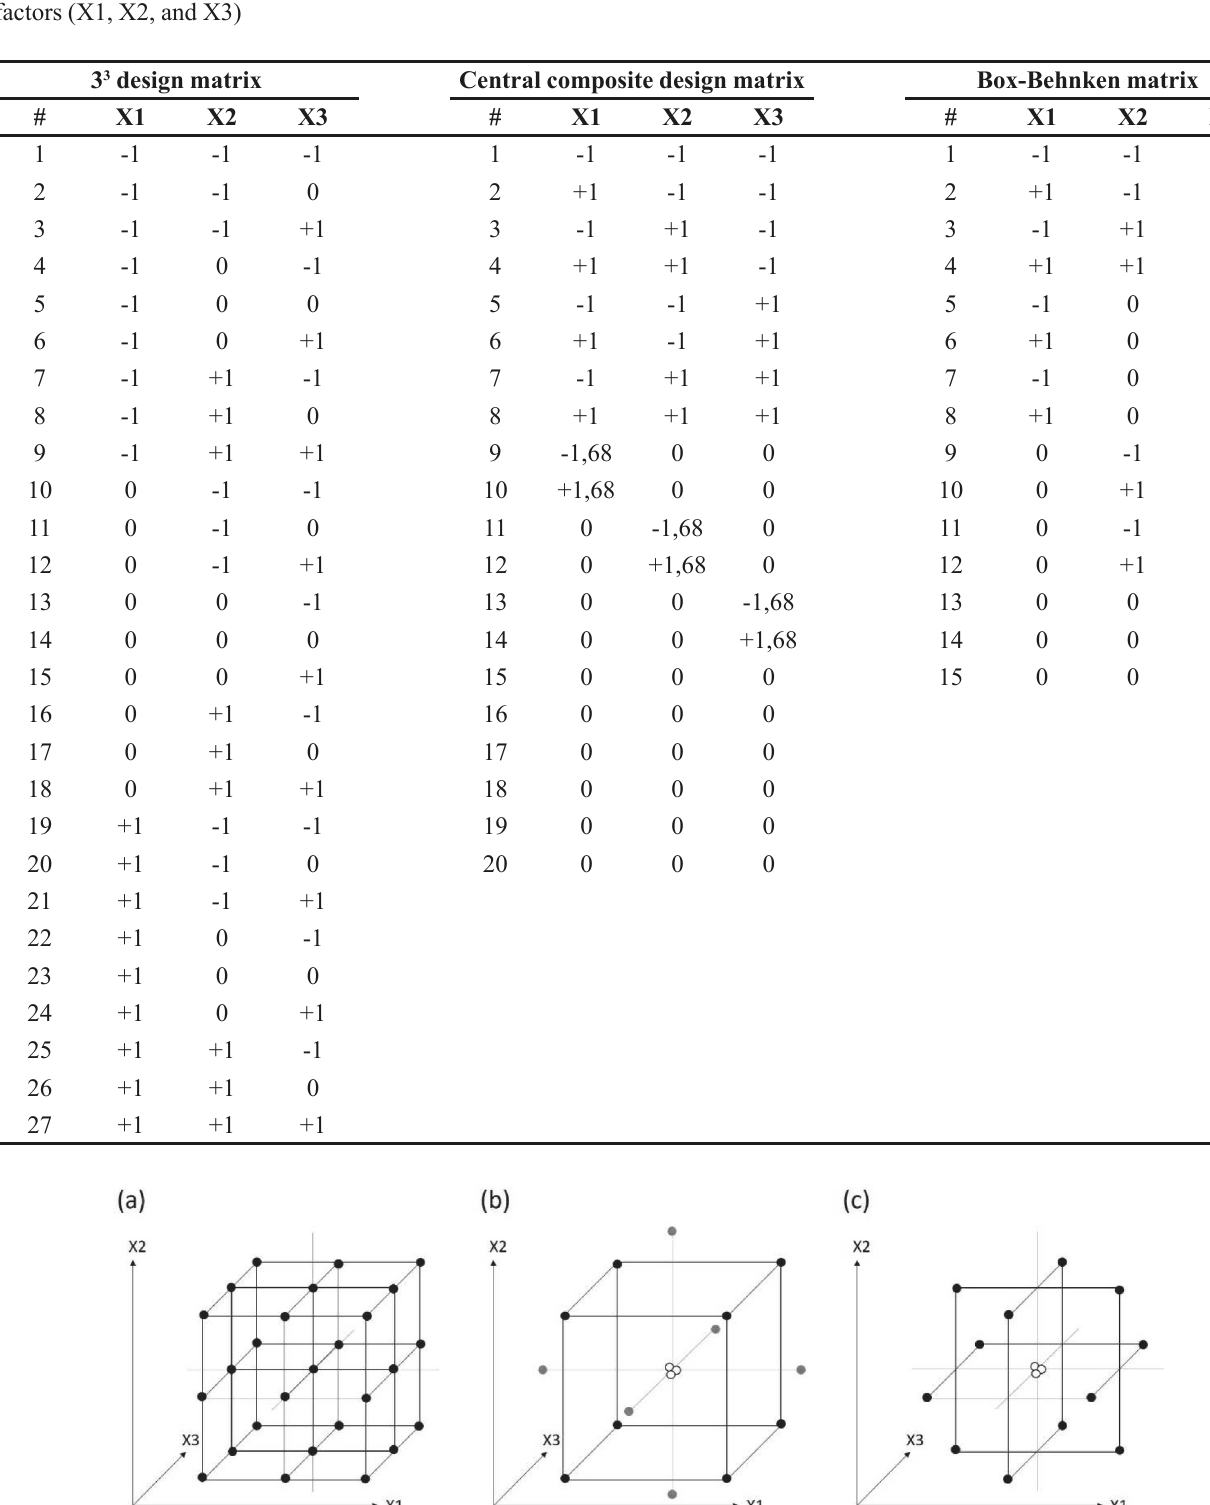
TABLE V – Three-level full factorial design (3 3 ), central composite design (CCD), and Box-Behnken design matrix for three input factors (X1, X2, and X3)